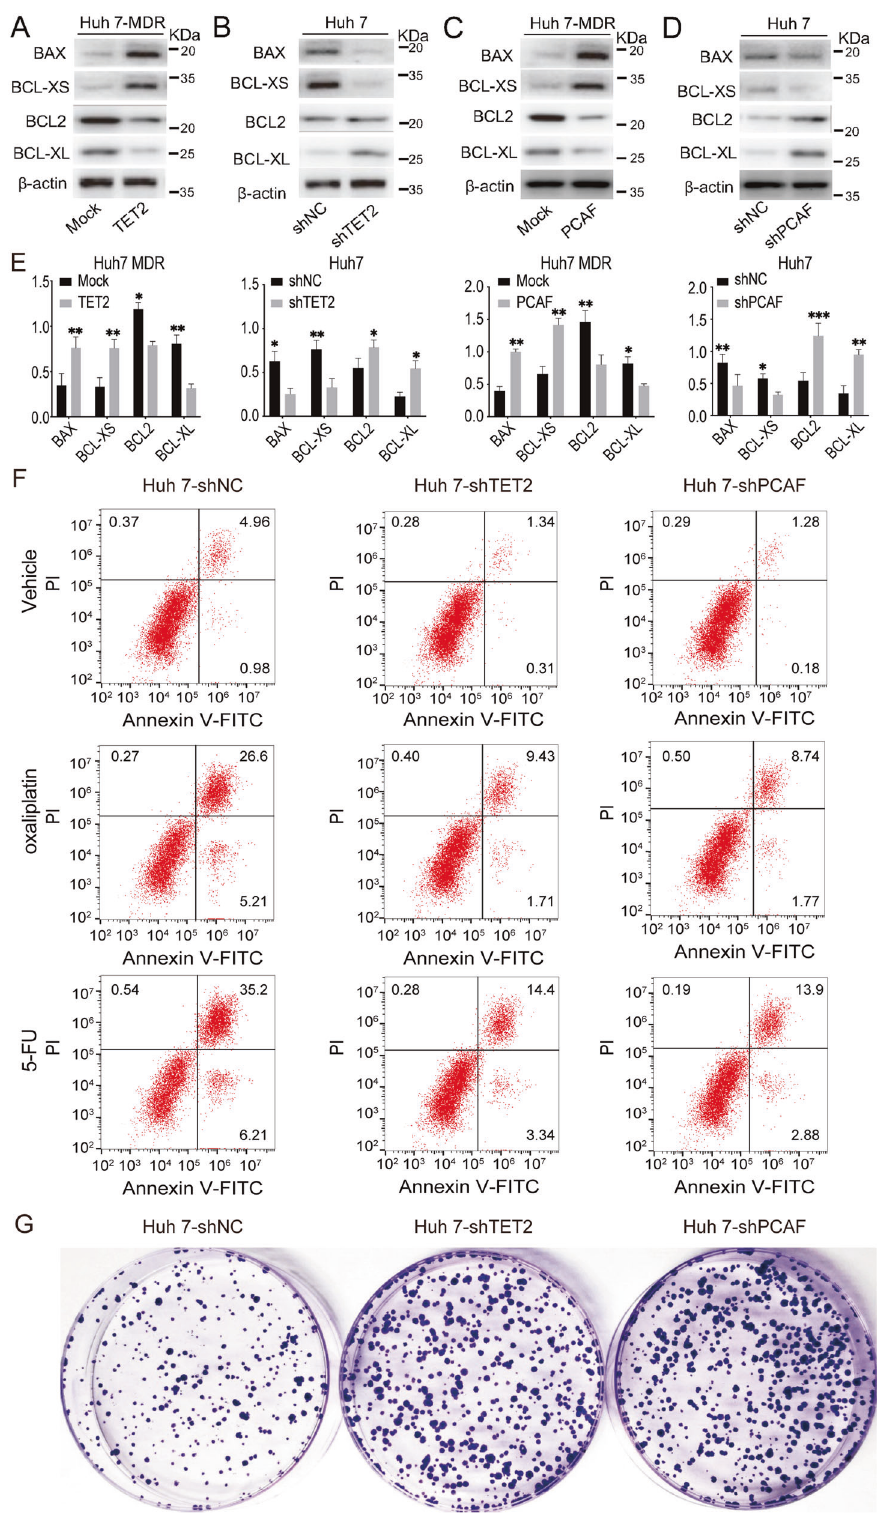
Fig. 6 TET2 induces HCC apoptosis through a TET2/PCAF axis. A Western blot showing the apoptosis-related and anti-apoptosis proteins expressed in Huh 7-MDR cells with forced expression of TET2. B Western blot showing the apoptosis-related and anti-apoptosis proteins expressed in Huh 7 cells with reduced expression of TET2. C Western blot showing apoptosis-related and anti-apoptosis protein expression in Huh 7-MDR cells with forced expression of PCAF. D Western blot showing the apoptosis-related and anti-apoptosis protein expression in Huh 7 cells with reduced expression of PCAF. E Quanti fi cation of apoptosis-related protein expression in Huh7, Huh7-shPCAF, Huh7-shTET2, Huh7 MDR and Huh7 MDR with forced expression of TET2 or PCAF; n = 3, t test, * P < 0.05; ** P < 0.01; *** P < 0.001. F The apoptosis rate of oxaliplatin or 5-FU treated Huh7-NC, Huh7-shTET2, and Huh7-shPCAF cells were assessed by FCM. G Proliferation in HCC cells with reduced expression of TET2 or PCAF was assessed by clonal formation assay. Cell Death and Disease (2023)